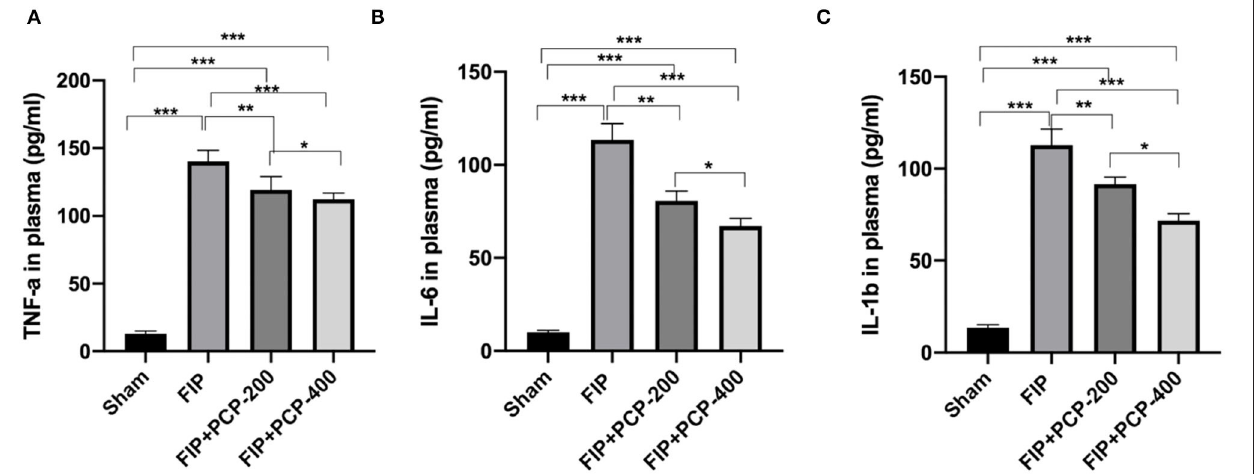
FIGURE 3 | PCP pretreatment inhibited the inflammatory response in FP-induced septic mice. (A) TNF- α in plasma in each group. (B) IL-6 in plasma in each group. (C) IL-1 β in plasma in each group. * P < 0.05; ** P < 0.01, *** P < 0.001, FIP + PCP-200 = FIP with PCP 200 mg/kg/day; FIP + PCP-400 = FIP with PCP 400 mg/kg/day. All presented data are a composite of three independent experiments. n = 5 in each group.